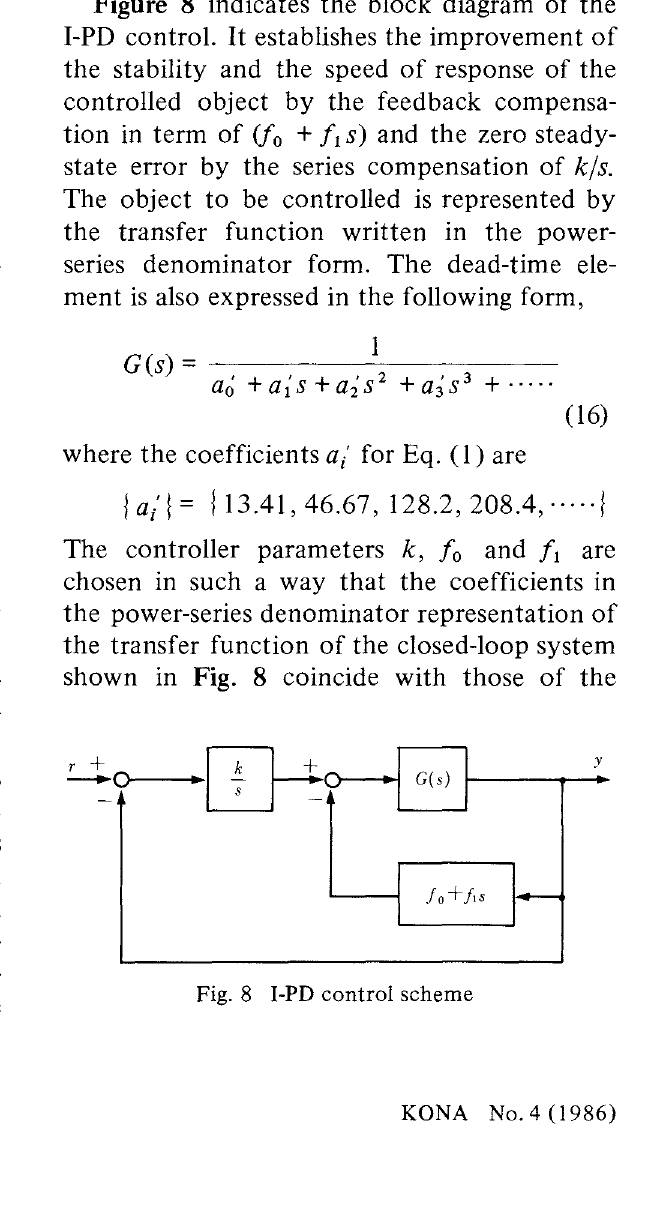
Fig. 8 1-PD control